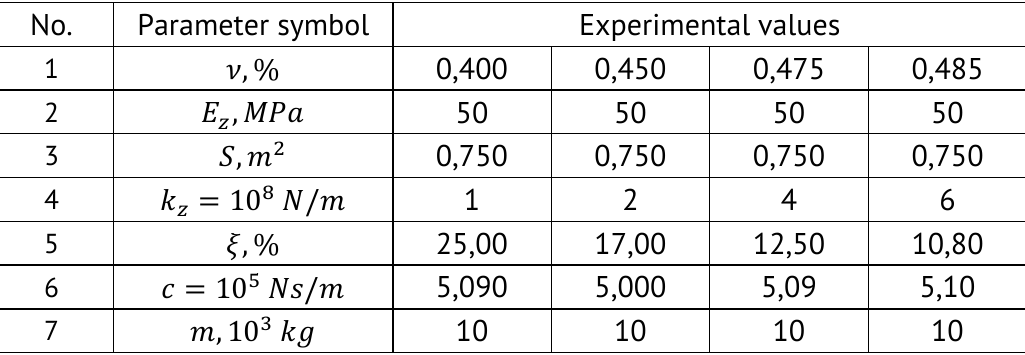
Experimental parameter